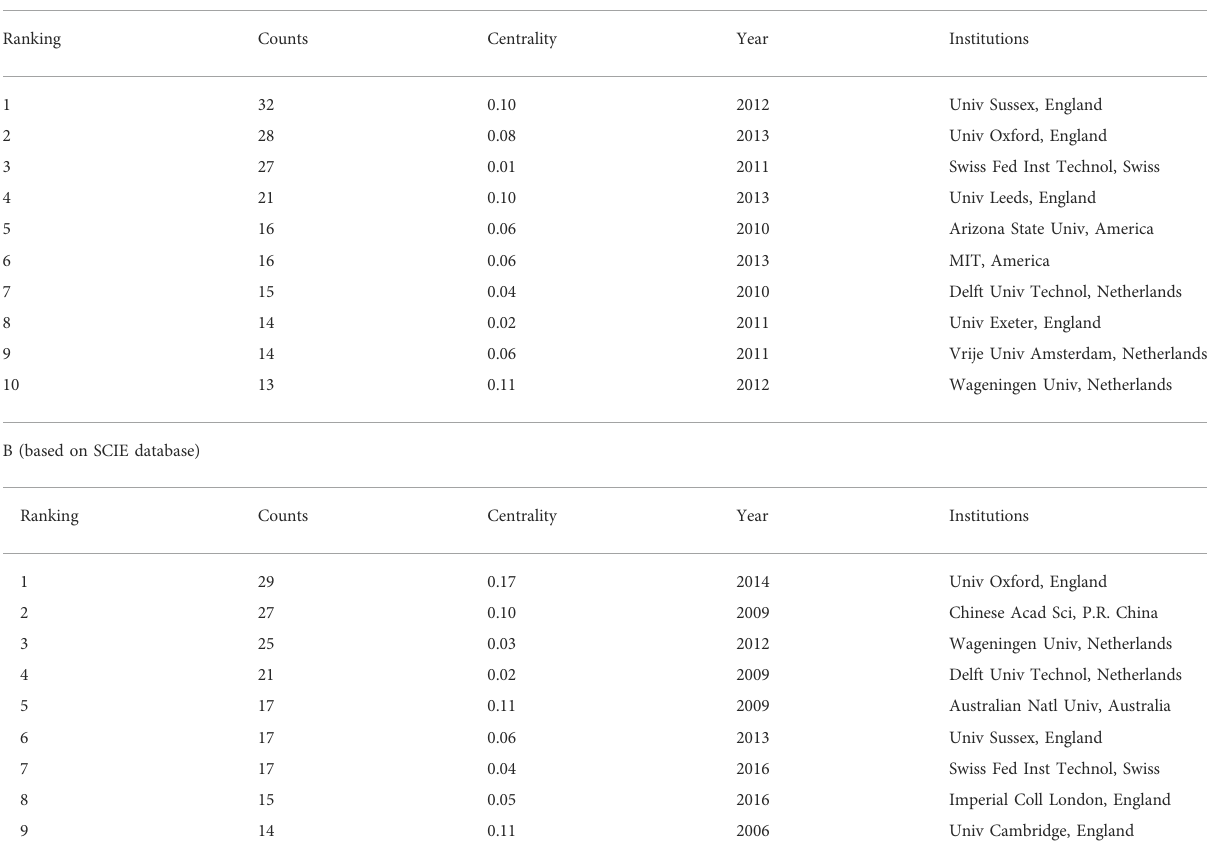
TABLE 2 Top 10 most productive institutions in climate innovation